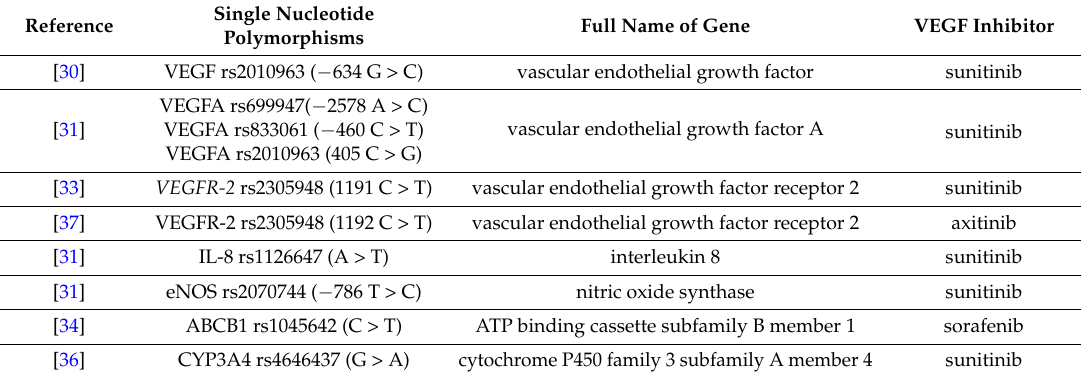
Table 3. Single Nucleotide Polymorphisms associated with higher risk of development of